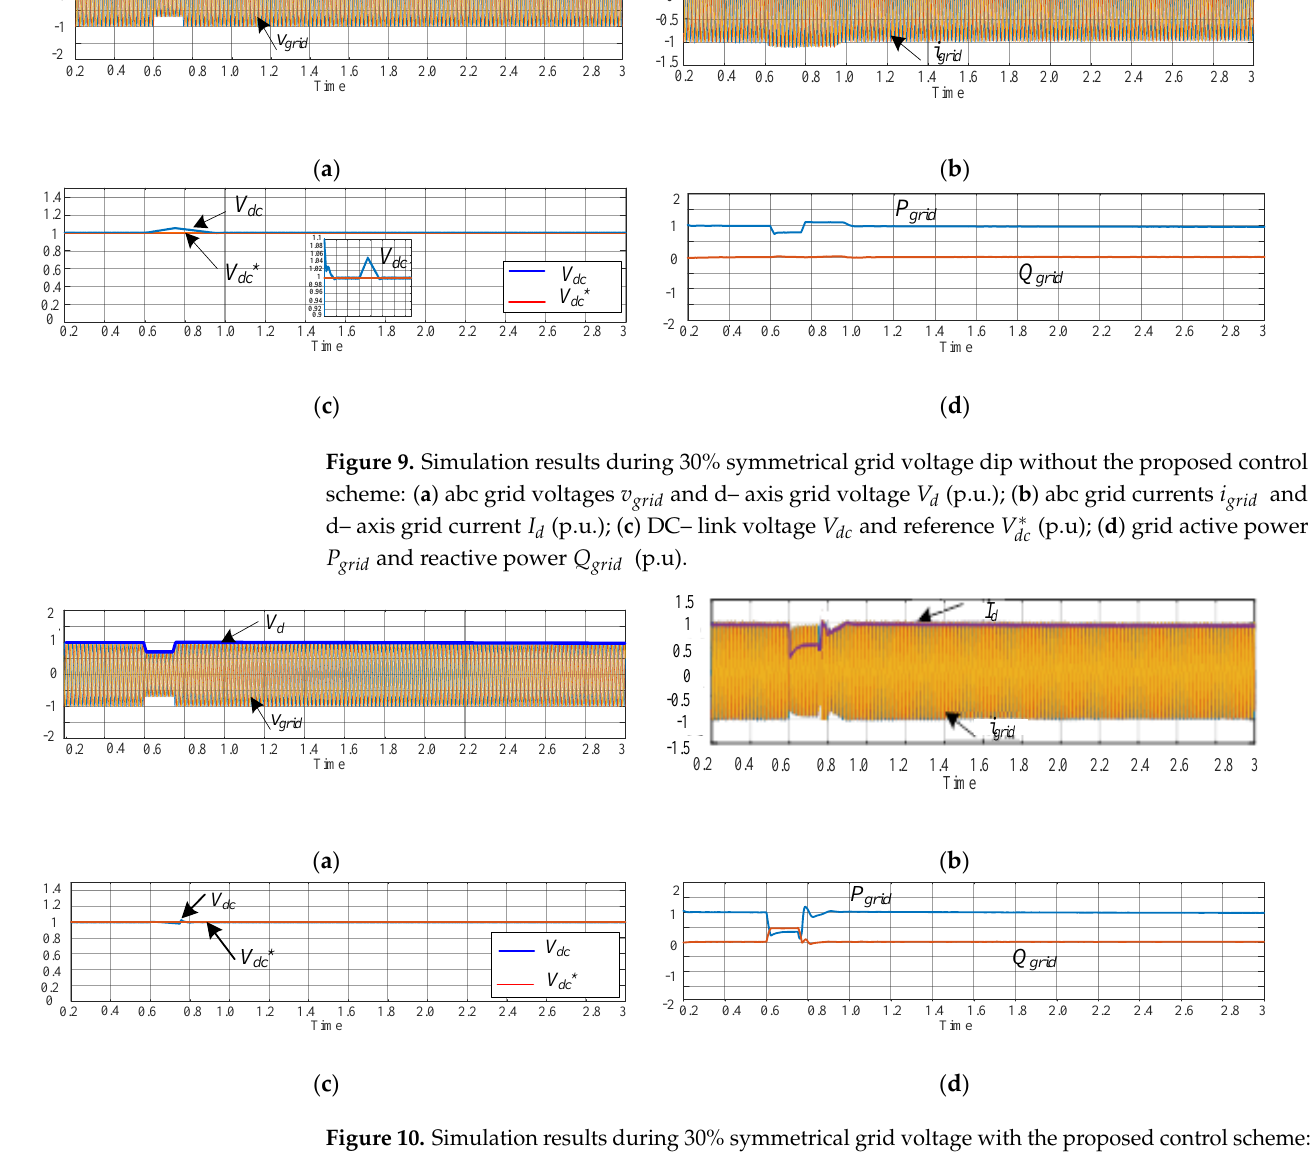
Figure 10. Simulation results during 30% symmetrical grid voltage with the proposed control scheme: ( a ) abc grid voltages 𝑣 𝑔𝑟𝑖𝑑 and d– axis grid voltage 𝑉 𝑑 (p.u.); ( b ) abc grid currents 𝑖 𝑔𝑟𝑖𝑑 and d– axis grid current 𝐼 𝑑 (p.u.); ( c ) DC– link voltage 𝑉 𝑑𝑐 and reference 𝑉 𝑑𝑐∗ (p.u); ( d ) grid active power 𝑃 𝑔𝑟𝑖𝑑 and reactive power 𝑄 𝑔𝑟𝑖𝑑 (p.u).